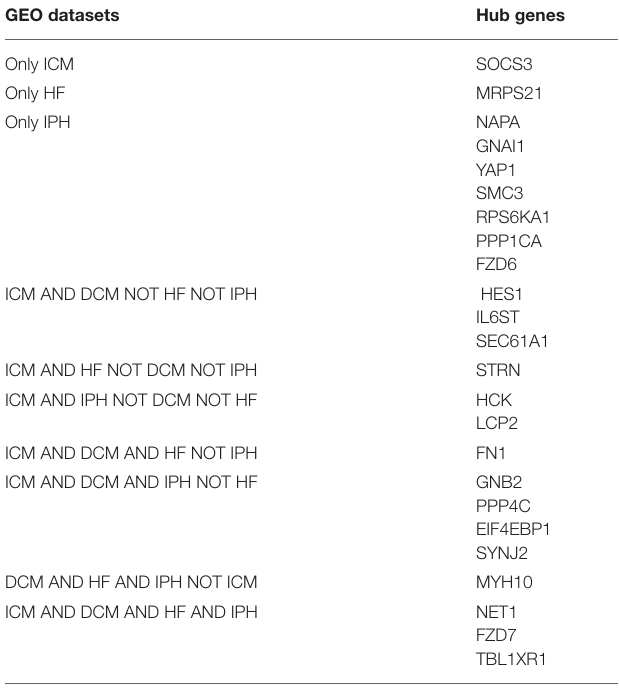
TABLE 4 | The hub genes validated in GEO datasets. GEO